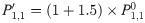
Distribution of conditional signal delay for network count data aggregated at W = 1 level.P1,1′=(1+1.5)×P1,10.